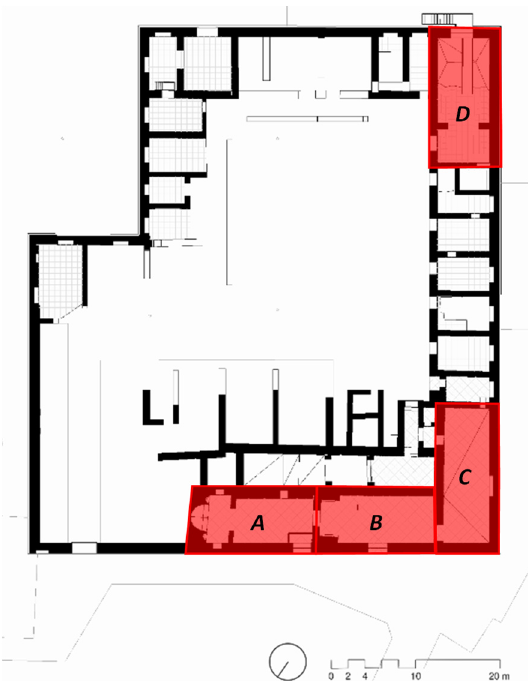
Figure 3. Plan of Castle of Maredolce: A) Chapel of St. Philip, B) “ Aula Regia” , C) Prayer Room, D) “ Sala dell’Imbarcadero” .